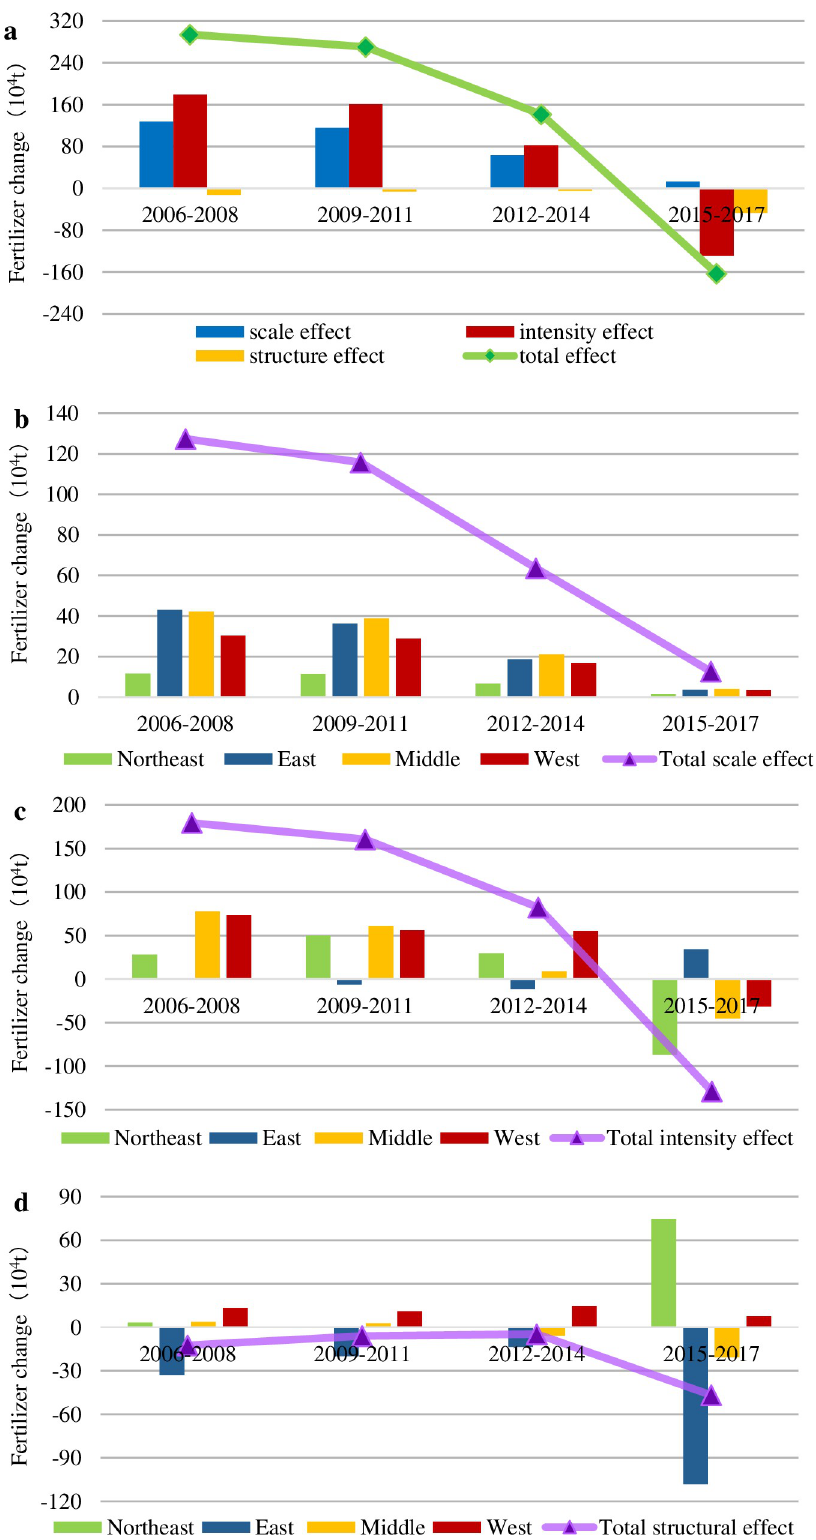
Fig 5. The total effect, scale effect, intensity effect and structure effect based on regions perspective. (a) Chinese FU variation decomposition based on regions;(b) Contributions of four regions to scale effect; (c) Contributions